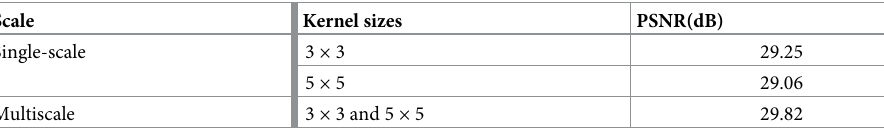
Table 1. PSNR comparison of different kernel sizes for the